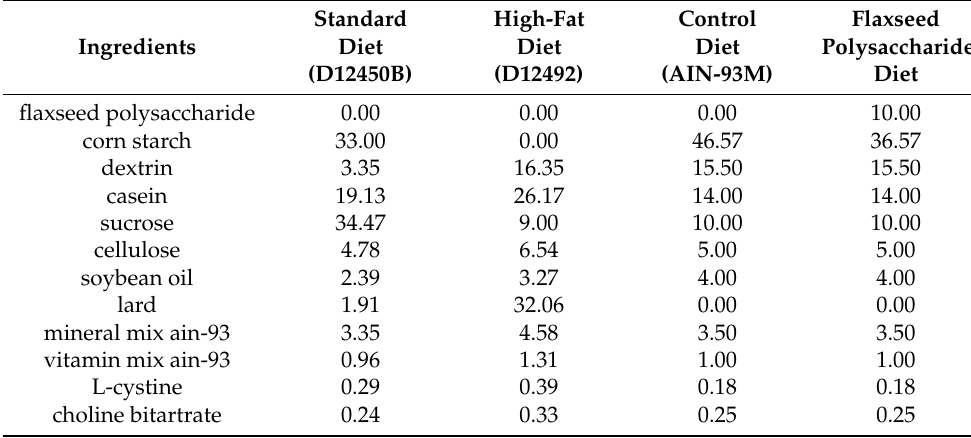
Table 1. Detailed recipes of each diet